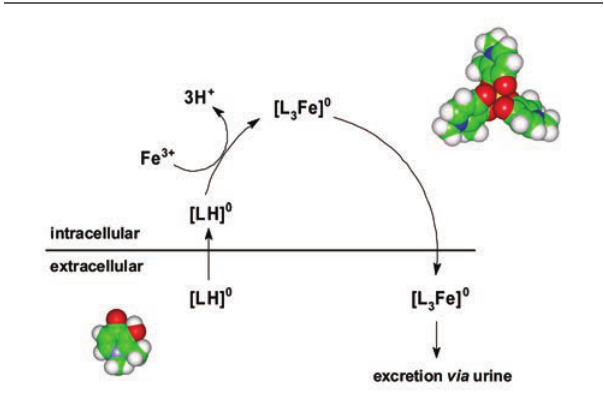
Figure 12. Schematic representation of the penetration of deferiprone [LH] O through the plasma membrane. The bidentate ligand scavenges loosely bound intracellular iron, forming the 3:1 complex which also carries zero net charge. Efflux as the iron complex leads to iron